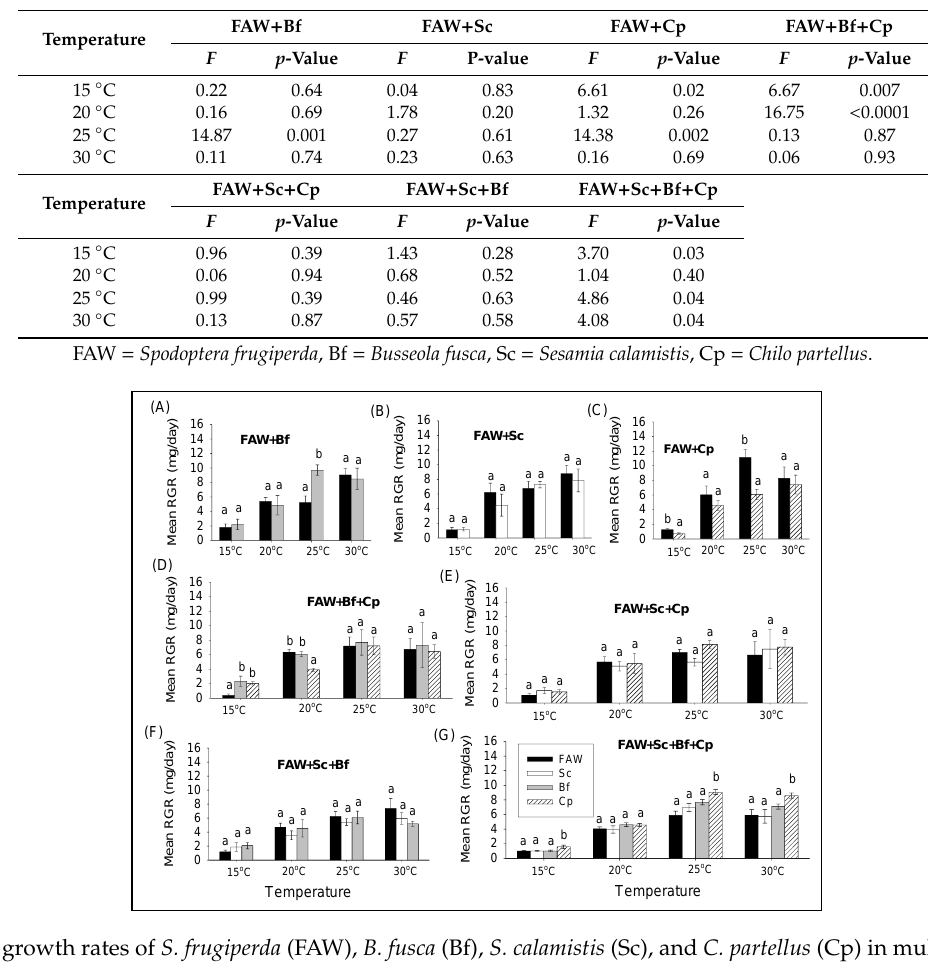
Table 4. Result of ANOVA comparing relative growth rates of fall armyworm vs. stemborer species in multi-species combinations at di ff erent constant temperatures.